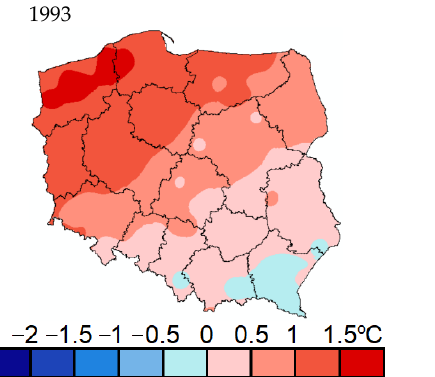
Figure 11. Spatial distribution of air temperature deviations in spring from the multi-year mean in the years when deficient precipitation covered the largest area of Poland.